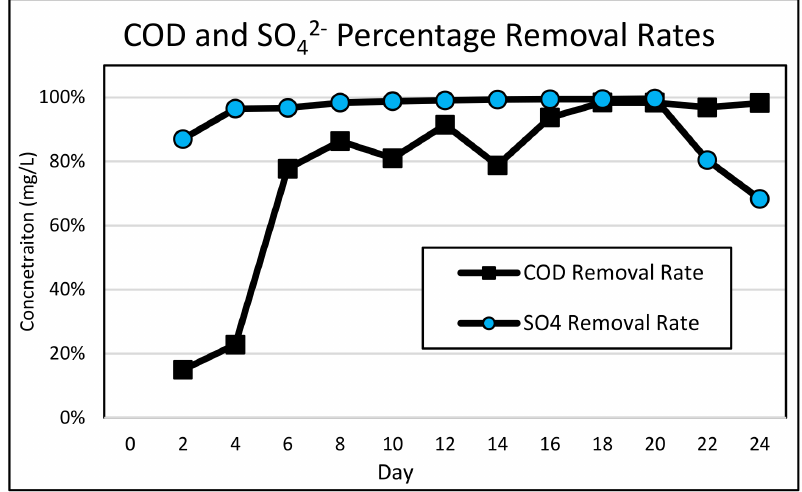
Figure 9. COD and SO 42 − percentage removal rates.